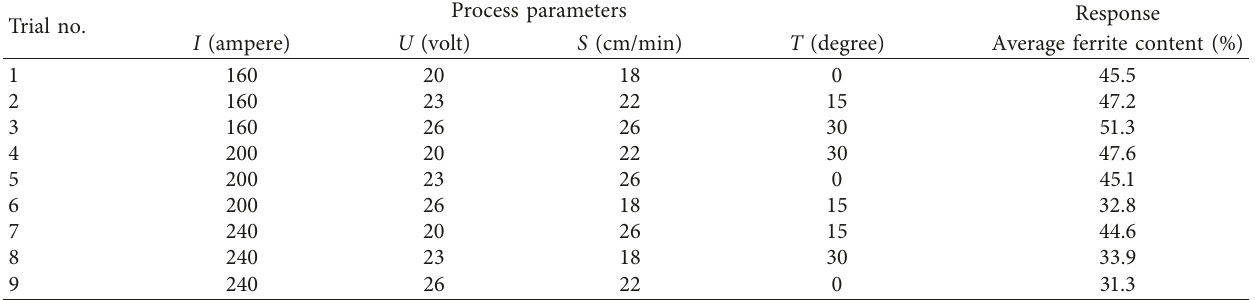
Table 3: Design matrix with measured responses.